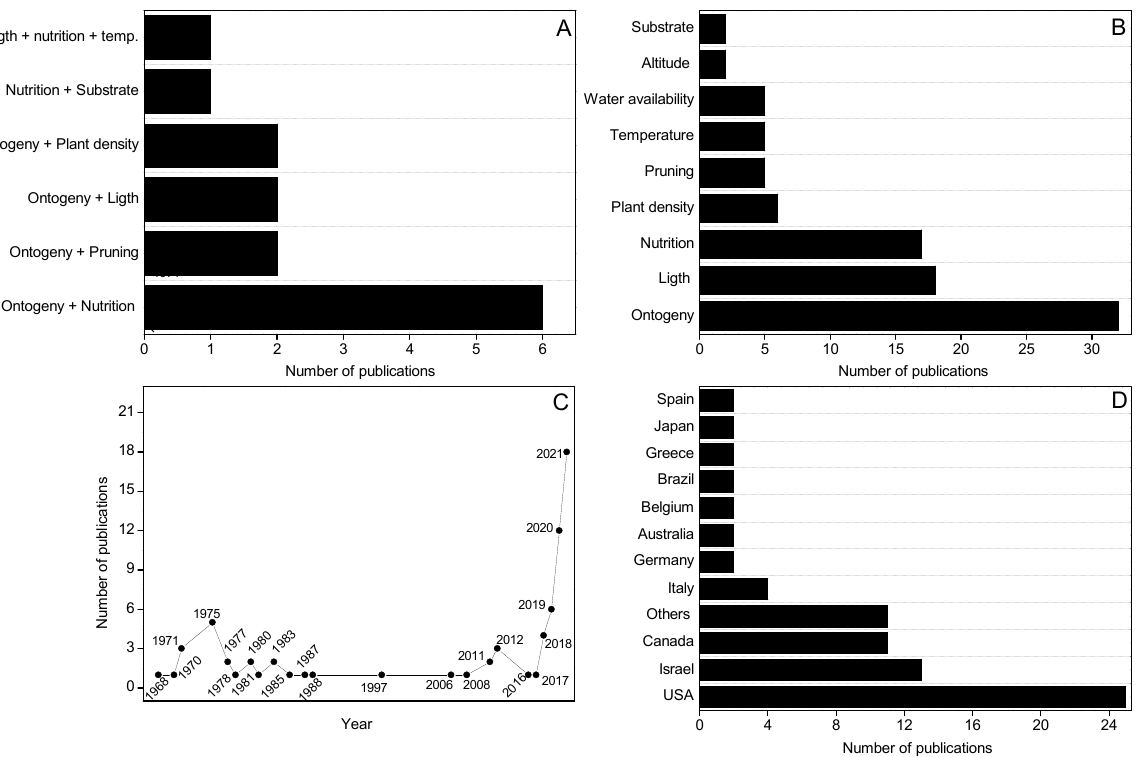
Figure 2. ( A ) Number of publications that evaluated two factors related to management and/or environment in the production of cannabinoids; ( B ) Number of publications that evaluated the management and/or environment in the production of cannabinoids; ( C ) Analysis of cannabis. literature about crop management and abiotic factors that affect cannabinoid production in terms of years and number of publications published; ( D ) Analysis of literature in terms of country and number of publications published.